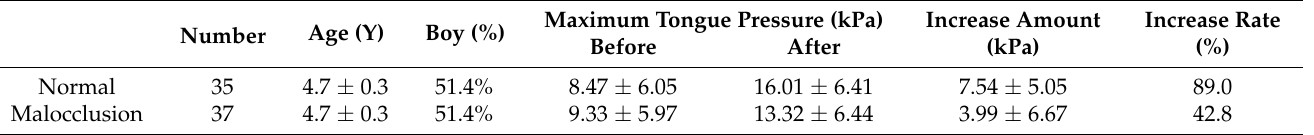
Table 4. 1-year follow-up measurements of children in the normal occlusion group and the malocclu- sion